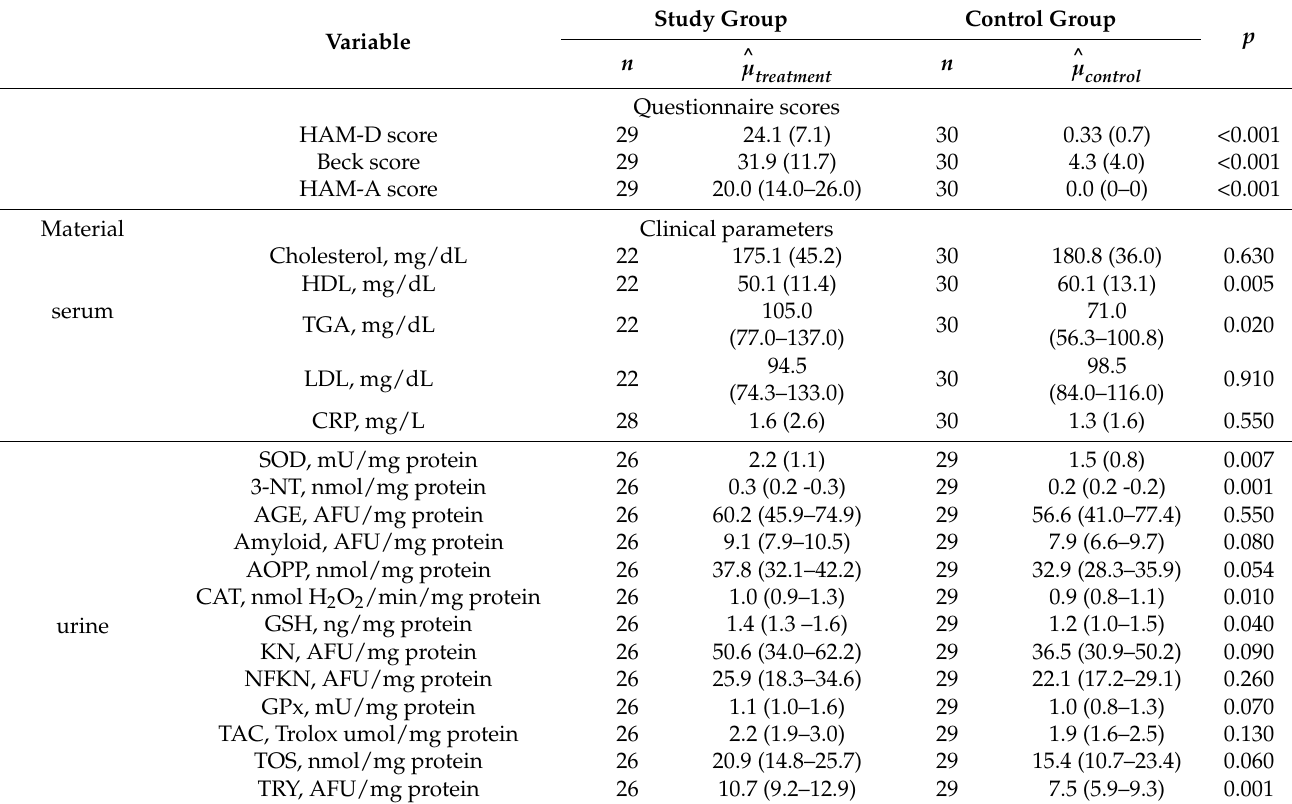
Table 1. From the data in Table 1, there were significant differences in all questionnaire scores and in seven biochemical parameters between the study and control groups. The group of depressed patients was characterized by higher mean questionnaire scores, higher mean concentrations of serum TGA and urine SOD, 3-NT, CAT, GSH, and TRY levels, and lower serum HDL concentrations. All significant differences were characterized by large effect